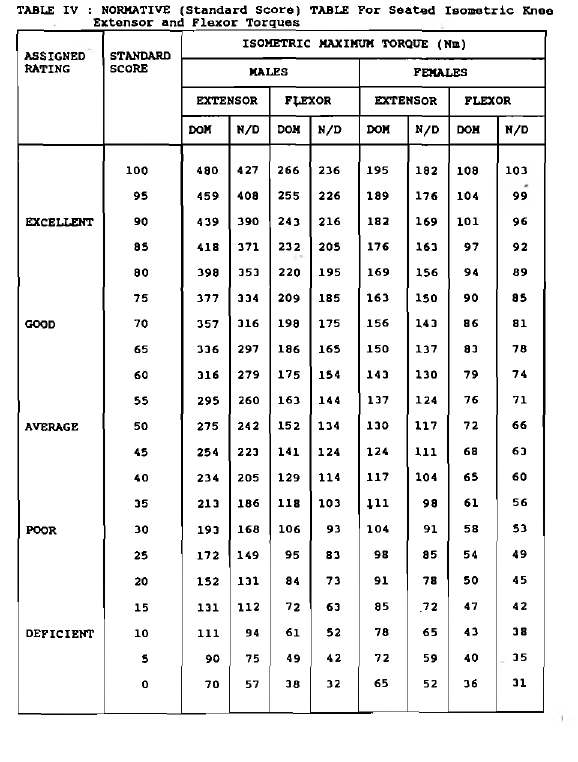
TABLE IV : NORMATIVE (Standard Score) TABLE For Seated Isometric Knee Extensor and Flexor Torques ISOMETRIC MAXIMUM TORQUE (ND) STANDARD ASSIGNED RATING SCORE